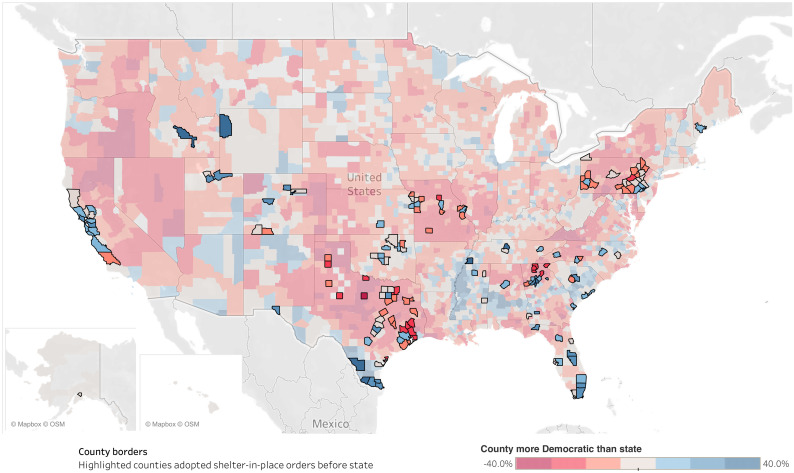
Distribution of county shelter-in-place orders by democratic vote share.Map of the contiguous United States showing that a county vote share from the 2016 Presidential election that contrasted with its state average was predictive of county shelter-in-place orders occurring before the state’s shelter-in-place orders. Counties that passed shelter-in-place policies prior to their states have highlighted borders. The majority of local orders were passed in counties that were more Democratic than their state or spatially proximal to such a county. Map illustrates author’s data using base map from Tableau, Mapbox, and OpenStreetMap made available under the Open Database License (https://www.openstreetmap.org/copyright).